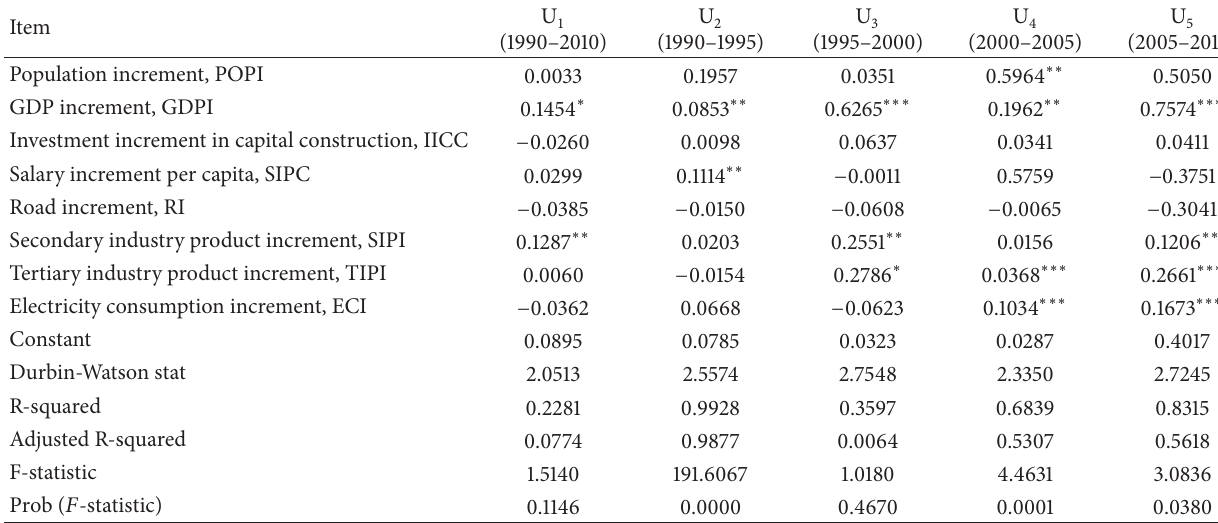
Table 5: Urban expansion and driving factors in Middle China.